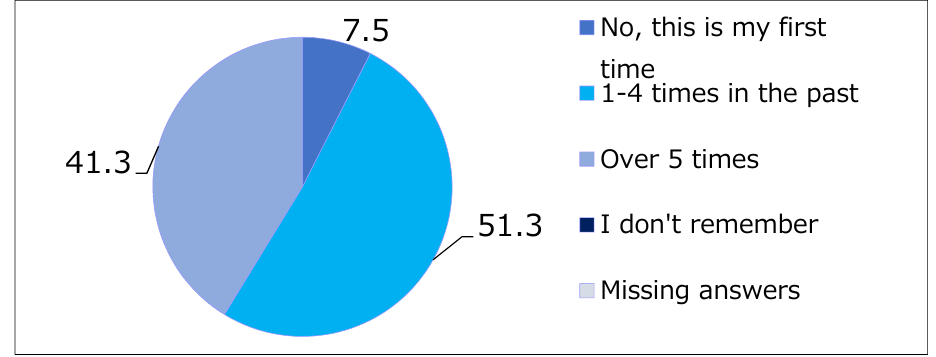
Figure 6. Answers for the question: Do you have previous experience of visiting this place (or surroundings)?